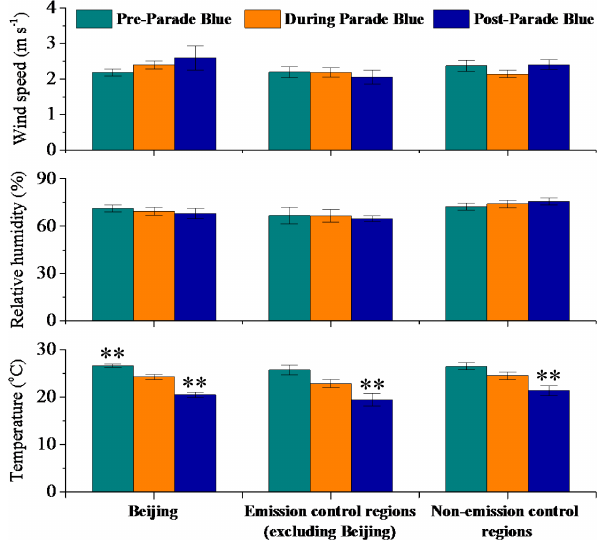
Figure 6. Comparison of wind speed (WS), relative humidity (RH) and temperature ( T ) between the Parade Blue period and non- Parade Blue periods (the pre-Parade Blue and post-Parade Blue pe- riods) in Beijing, emission control regions (excluding Beijing) and other cities in non-emission-control regions (two asterisk on bars denotes significant difference at p <